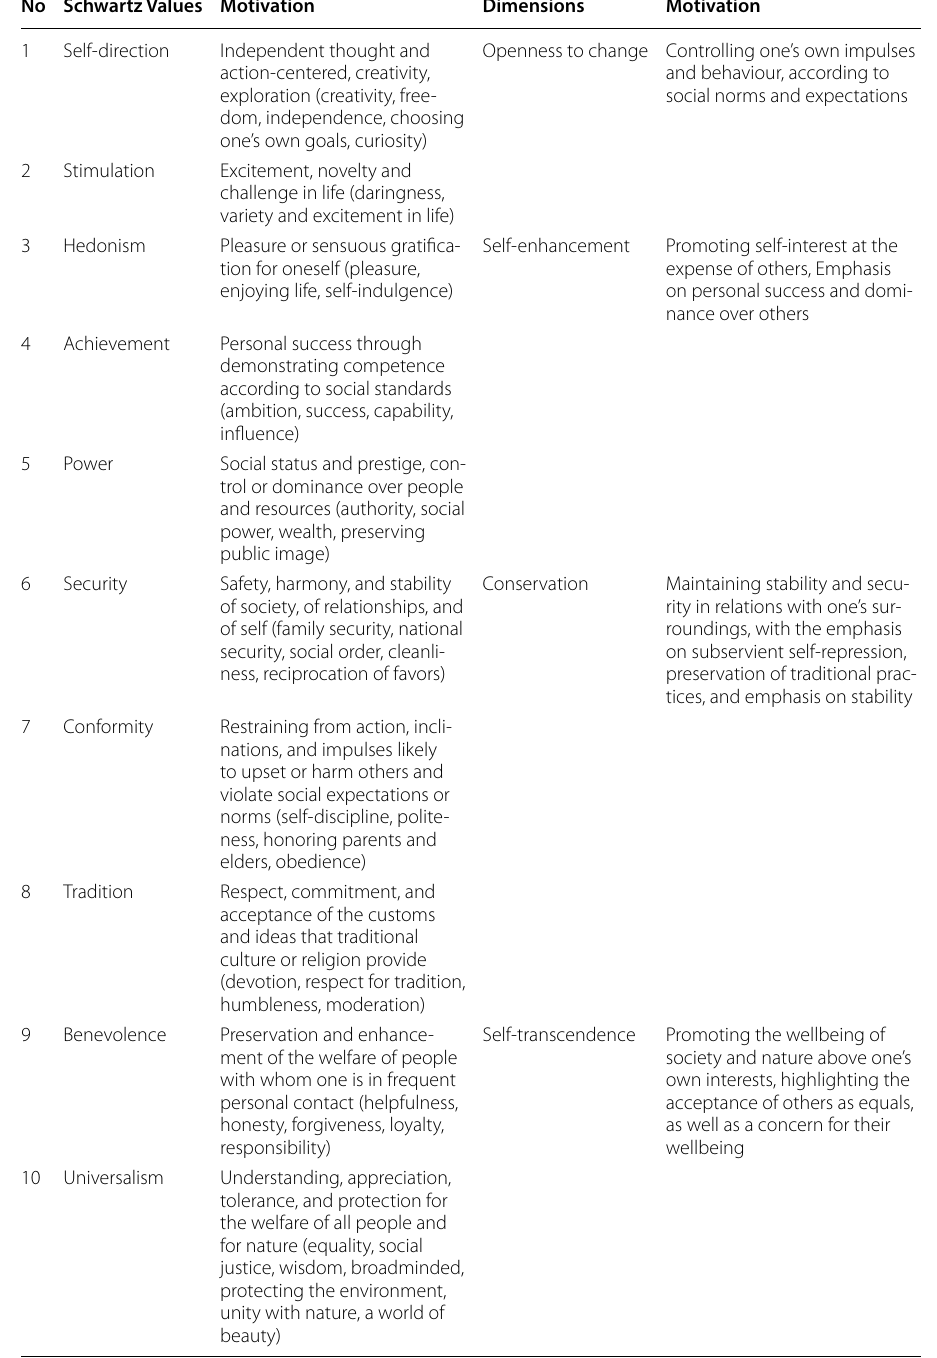
Table 8 Motivations (goals) of humans behind their values, and dimensions thereof. Source : adaptation based on Schwartz and Boehnke 2004; Giménez and Tamajón